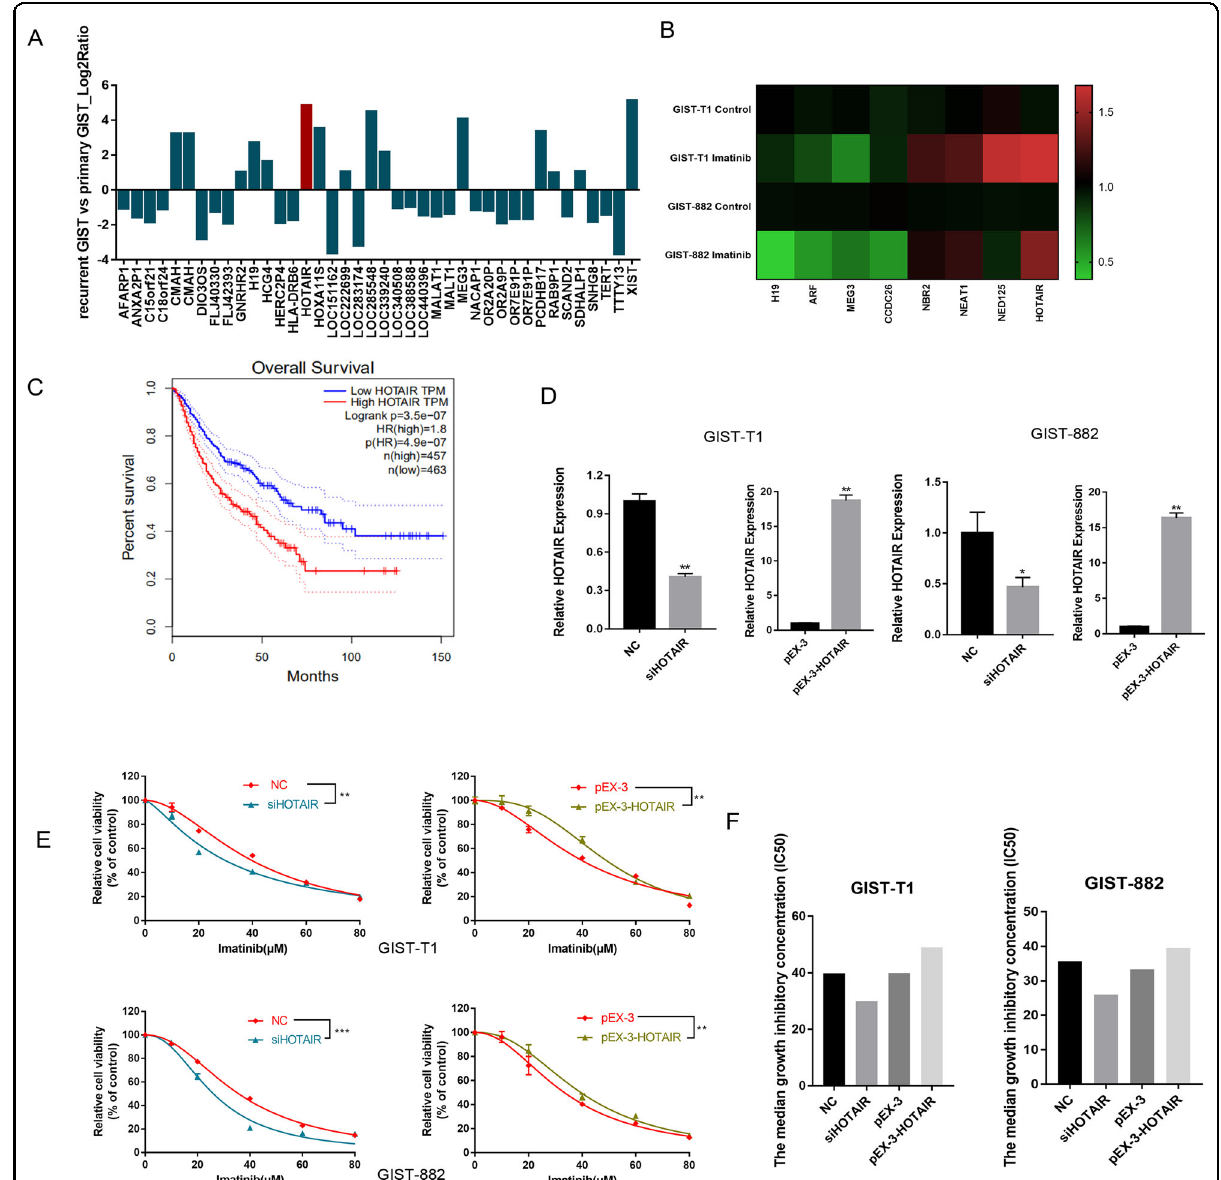
Fig. 1 HOTAIR is upregulated in recurrent GIST tissue and is associated with imatinib sensitivity. A Some of the lncRNAs that were differentially expressed in recurrent GIST tissues compared with that in primary GIST tissues. B Heat map of differentially expressed lncRNAs after imatinib treatment. C Overall survival based on the high expression of HOTAIR in several kinds of gastrointestinal tumors. D The change in HOTAIR expression after transfection, as assessed using qRT-PCR in GIST-T1 and GIST-882 cells. * P < 0.05, ** P < 0.01 vs. NC or pEX-3. E , F CCK-8 assays were performed to examine imatinib sensitivity of GIST cells, and the IC50 values are plotted as bar graphs. * P < 0.05, ** P < 0.01 vs.